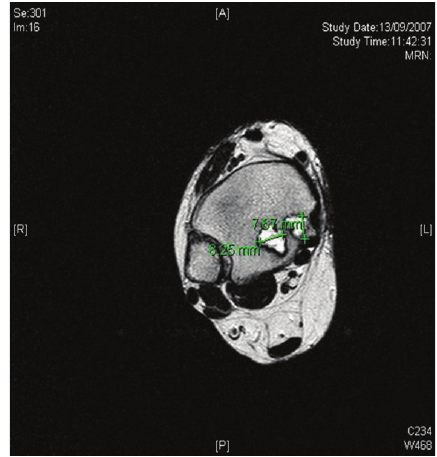
Figure 6: Axial view MRI showing well defined cystic fluid filled lesions in distal tibia.